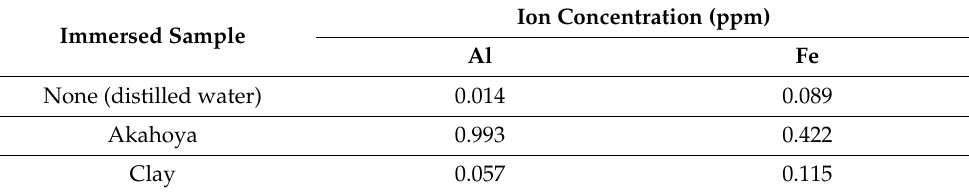
Table 2. Al and Fe ion concentrations in the immersion liquid containing an Akahoya or clay sample.